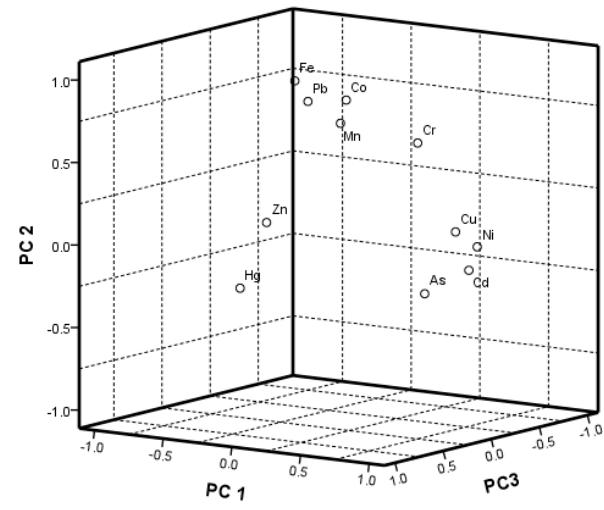
Figure 2. Loading plots of principal component factors of heavy metals in the study area.